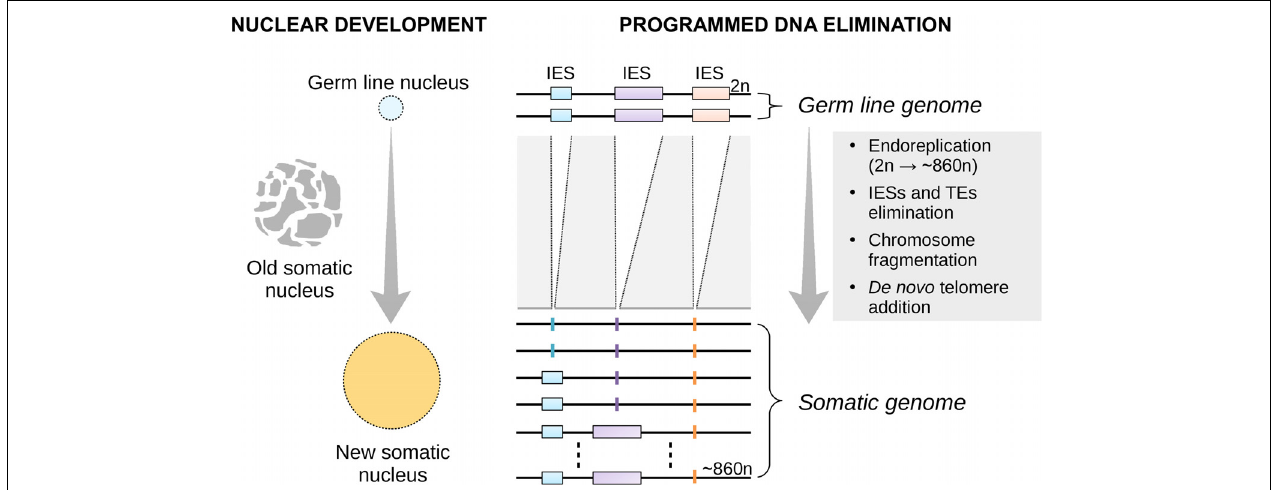
FIGURE 1 | Nuclear replacement and somatic genome development in Paramecium . Each time the single-celled Paramecium reproduces sexually, the old (parental) somatic nucleus is destroyed and replaced with a new one (left) . The new macronucleus develops from a copy of the zygotic micronucleus housing the germ line genome. The process of genome remodeling that accompanies nuclear development in Paramecium involves endoreplication, chromosome fragmentation and de novo telomerization, and the elimination of mostly germ line-restricted elements such as transposable elements (TEs) and Internal Eliminated Sequences (IESs) (right) . Only IES elimination is shown. This developmentally-regulated genome processing is known as Programmed DNA Elimination (PDE). PDE is crucial to reconstitute a functional somatic genome from an interrupted germ line